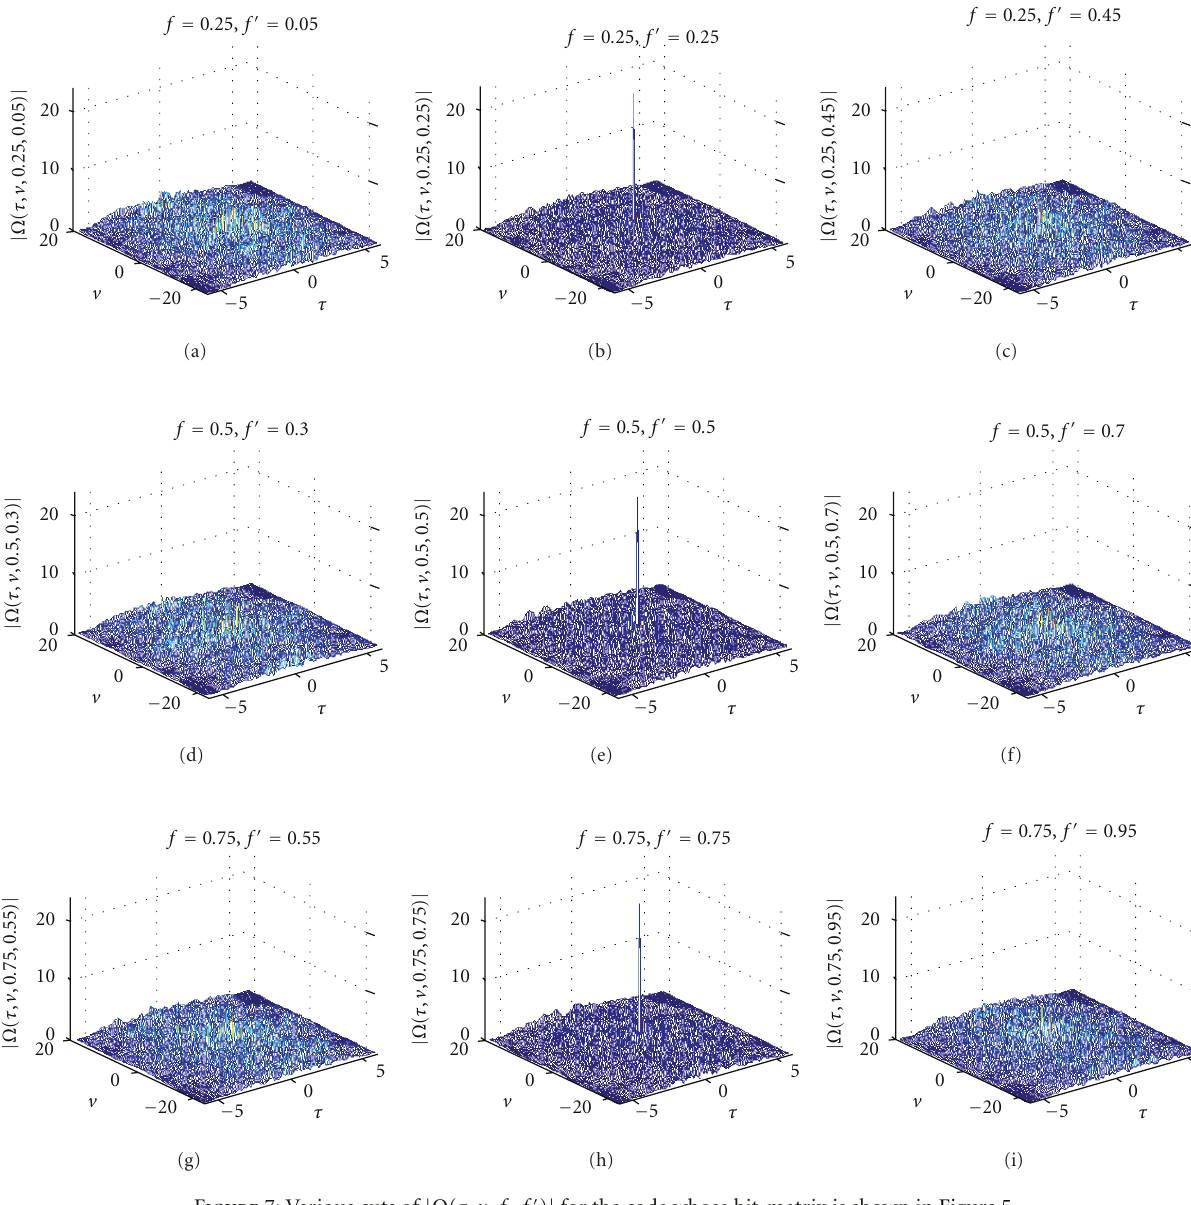
Figure 7: Various cuts of | Ω ( τ , ν , f , f (cid:6) ) | for the code whose hit-matrix is shown in Figure